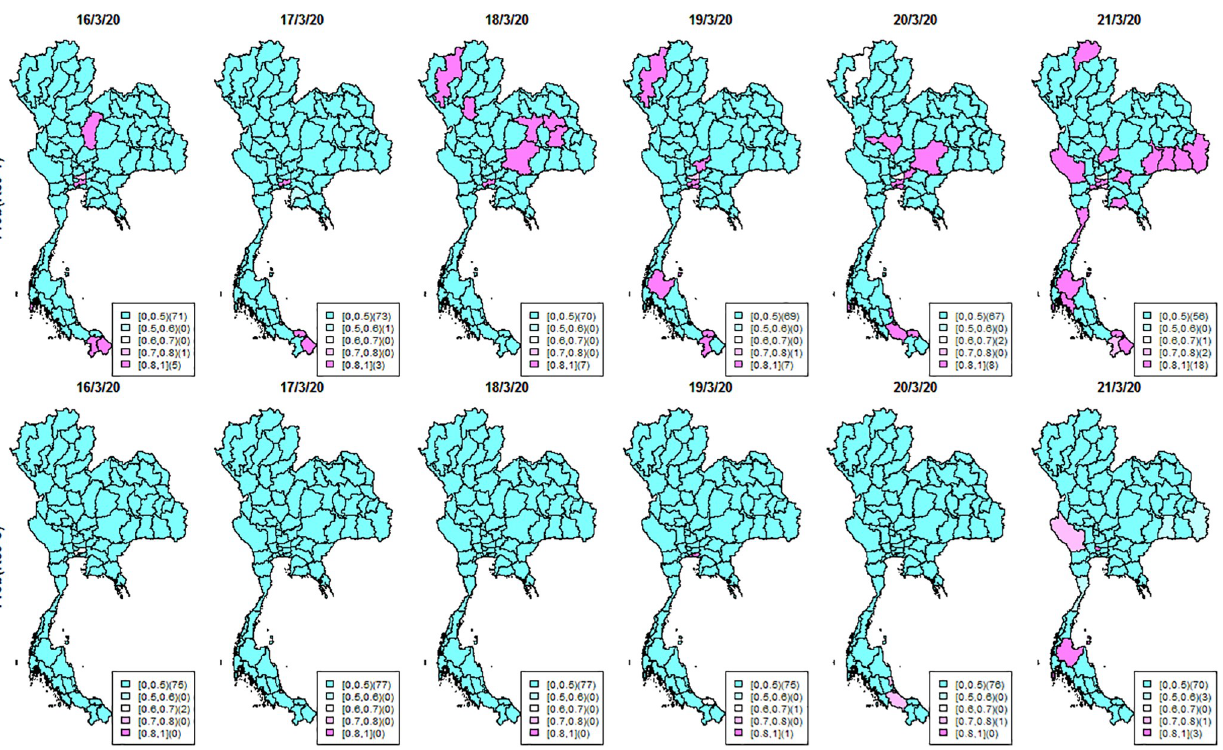
Fig 5. Maps of Thai COVID-19 exceedance probabilities of R at provincial level.